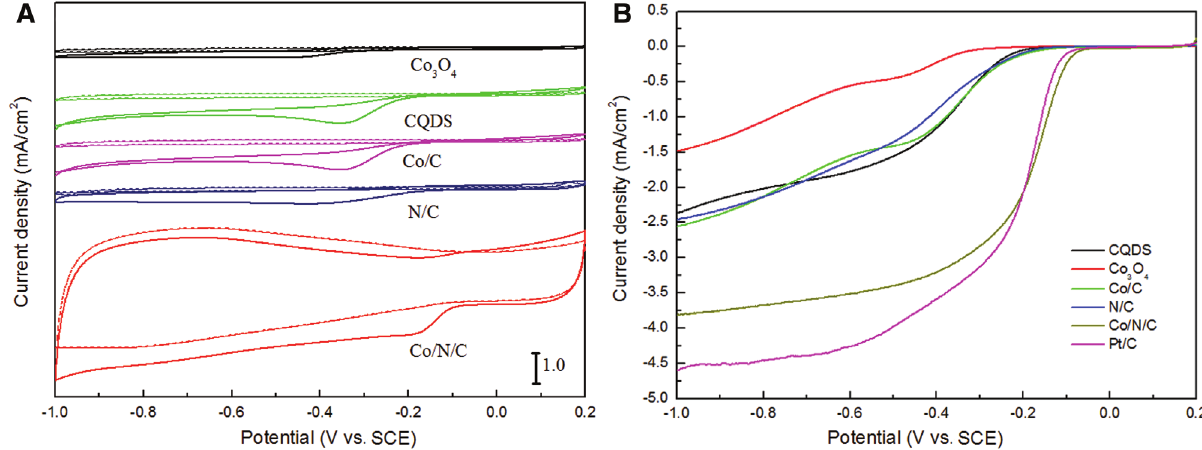
O , carbon quantum dots (CQDs), Co/C, N/C and Co/N/C in (solid line) O 3 4 -saturated 0.1 m KOH solution at a rotation rate of 1600 rpm and a scanning rate of 5 2